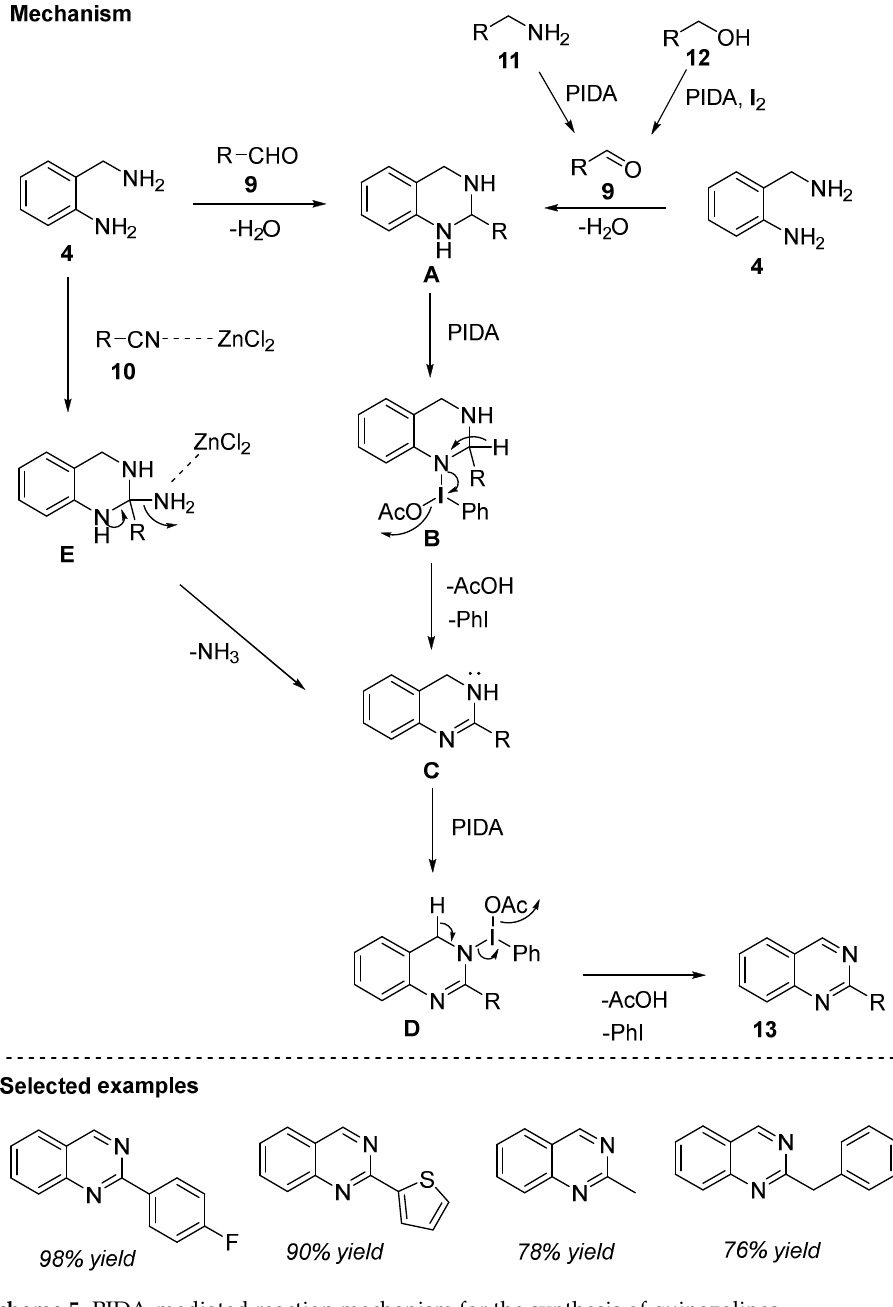
Scheme 5. PIDA-mediated reaction mechanism for the synthesis of